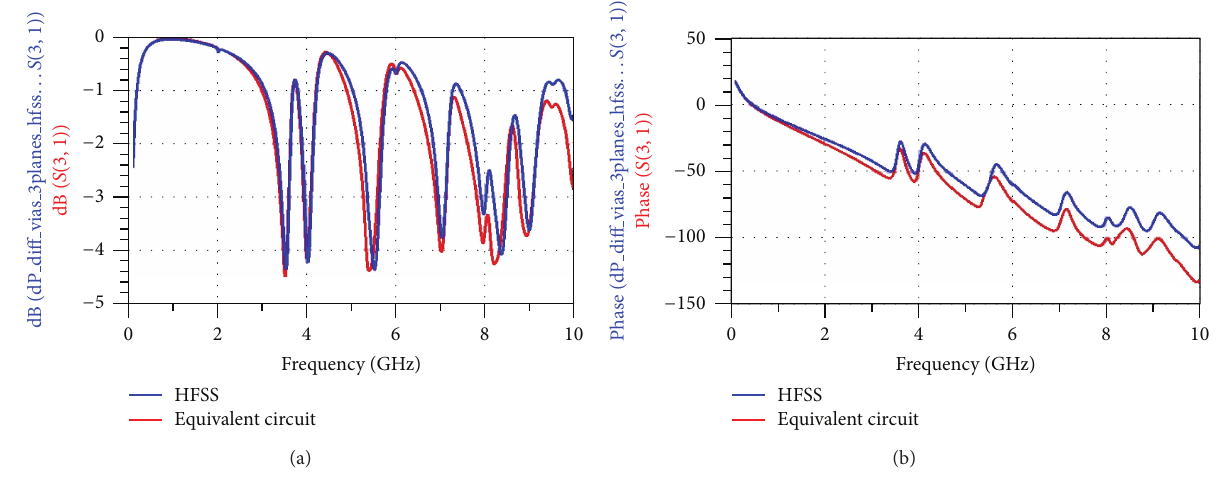
Figure 23: 𝑆 21 of differential vias in multilayer: (a) amplitude; (b)